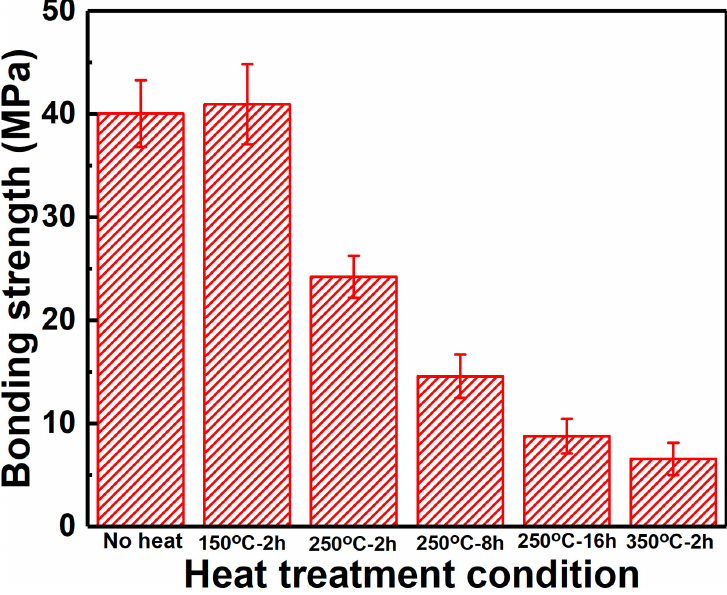
Figure 5. Bonding strength of Zn coatings after different heating conditions.